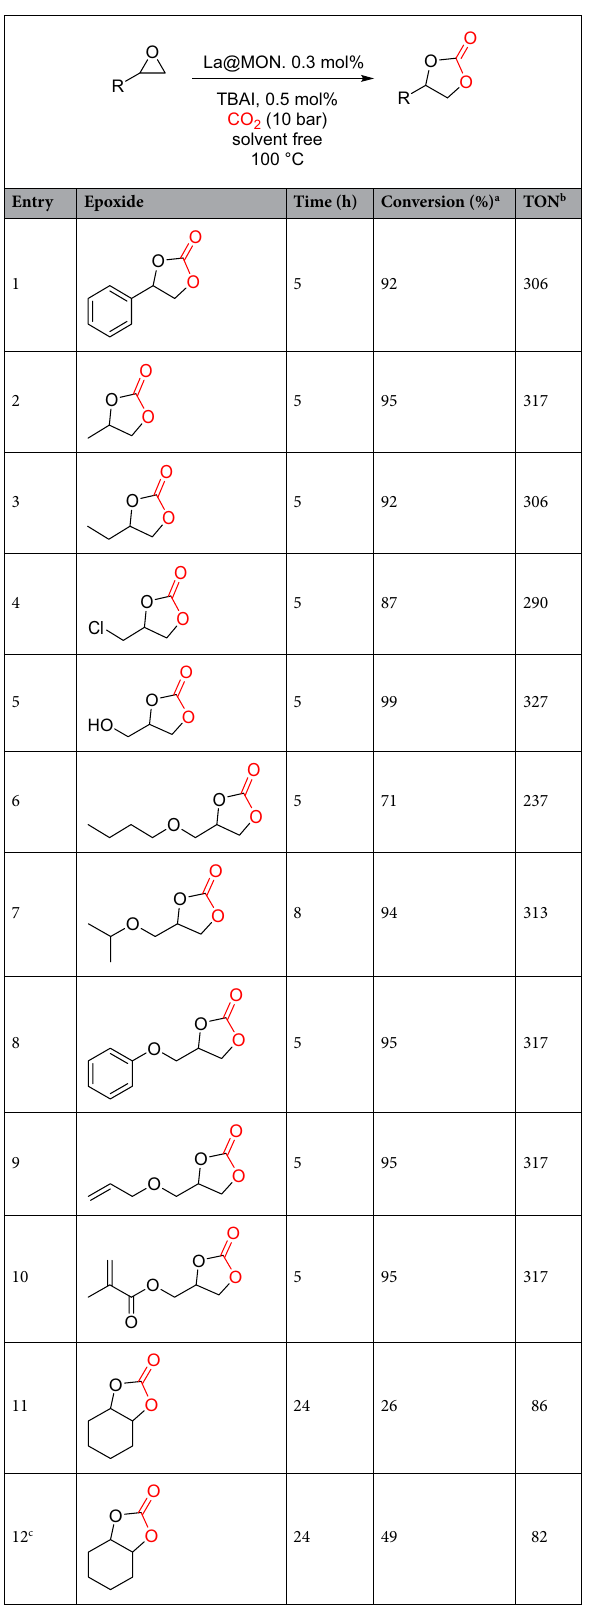
Table 4. Coupling of various epoxides with CO 2 catalyzed by La@MON. Reaction conditions: 5 mmol epoxides, 0.3 mol% La@MON, 0.5 mol% TBAI as co-catalyst, 10 bar CO 2 at 100 °C under solvent-free conditions. a All conversions were determined by the GC method with trimethylbenzene as the internal standard. All reaction selectivities were calculated to be more than 99% b TON: turnover number calculated by [(mmol of carbonate)/(mmol of La)]. c 0.6 mol % La@MON was